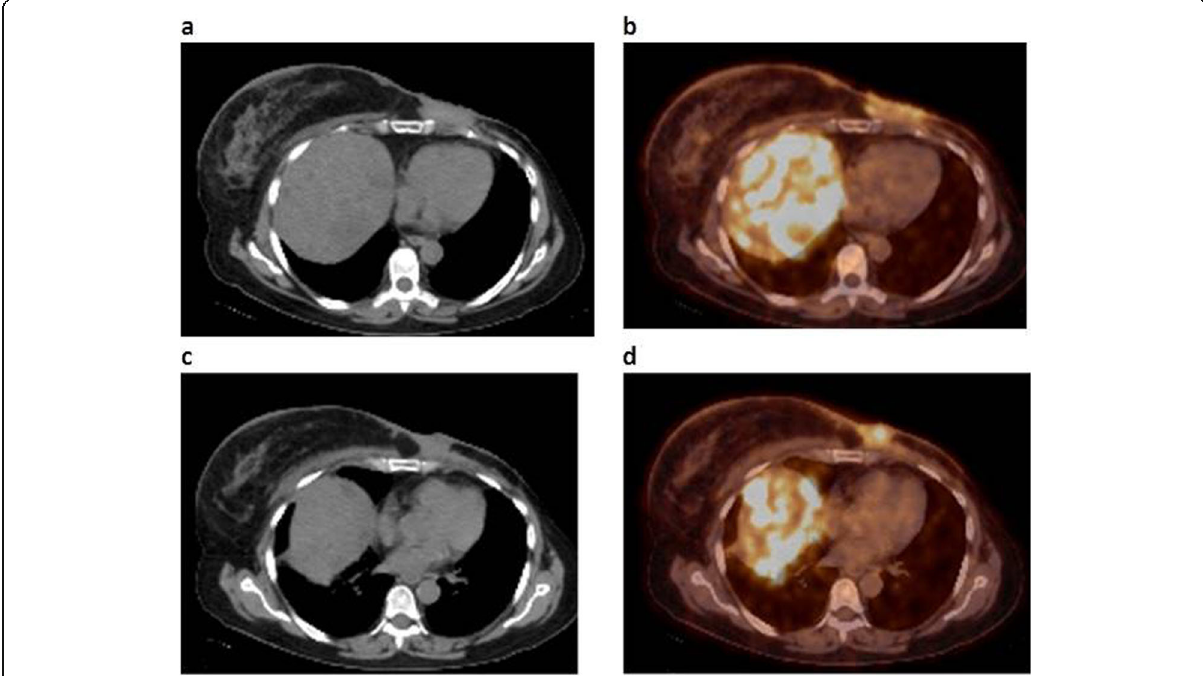
Fig. 6 56 years old female patient with history of left breast cancer, submitted for MRM followed by chemotherapy and hormonal treatment, presented with focal skin thickening at the operative bed, and histopathologicaly proven to be recurrent neoplasia (IDC basal subtype-tripple negative). Axial CECT and fused PET/CT images ( a , b ) revealed metabolically active soft tissue mass lesion measuring about 15 × 46 mm and